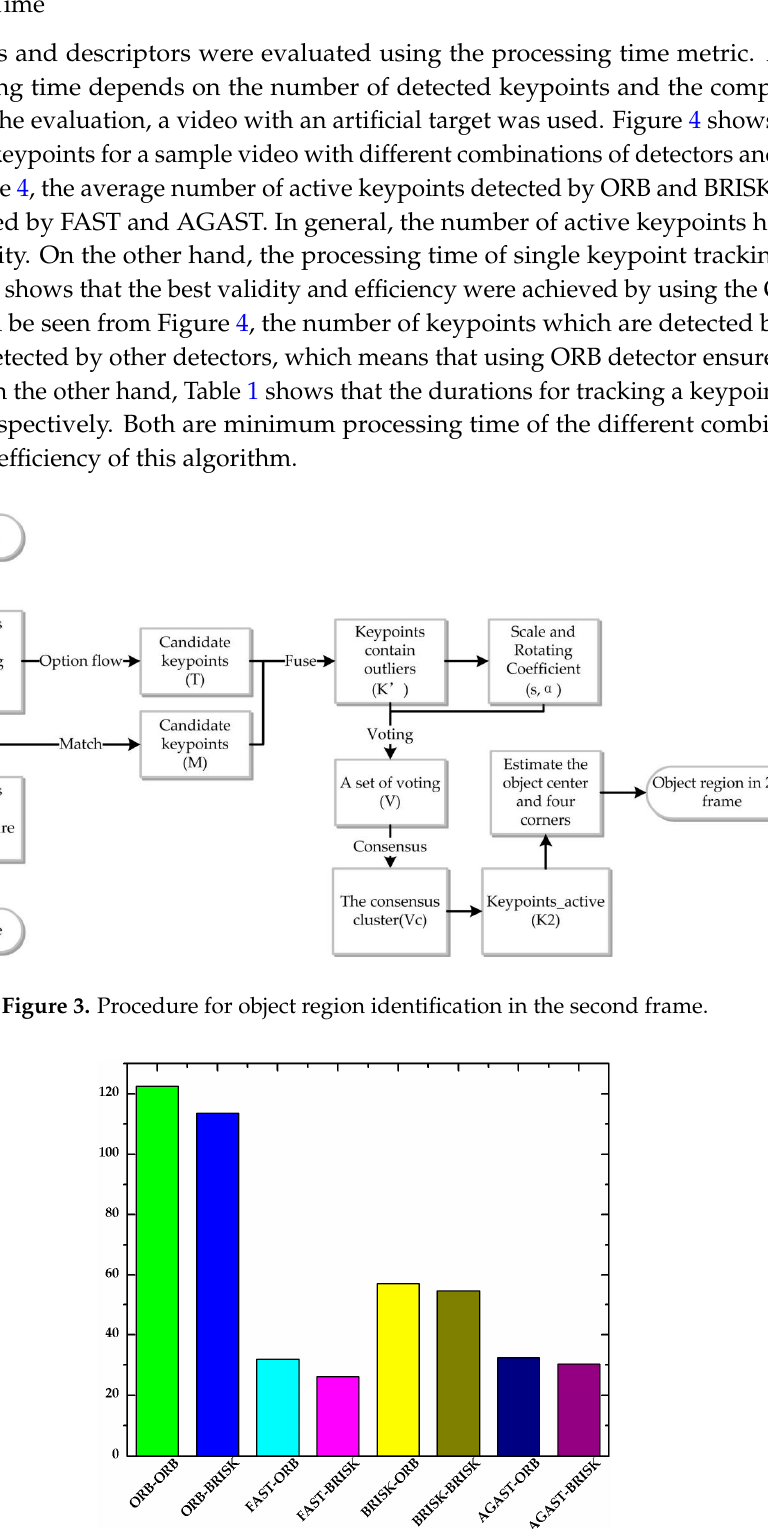
Figure 4. Average number of active keypoints for a sample video with different combinations of detectors and descriptors. Table 1. Processing time of different combination pairs.